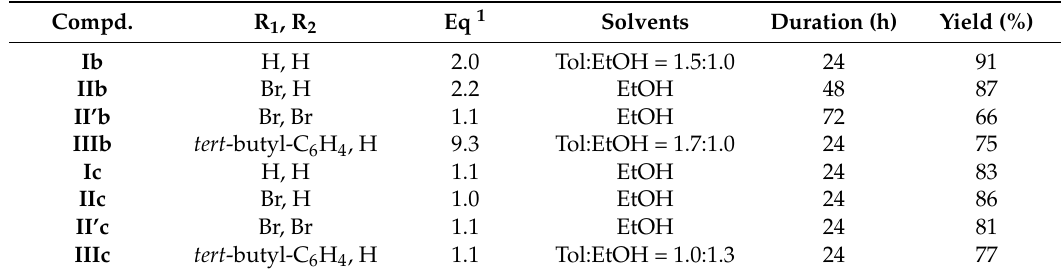
Table 1. Experimental conditions for Knoevenagel condensations.